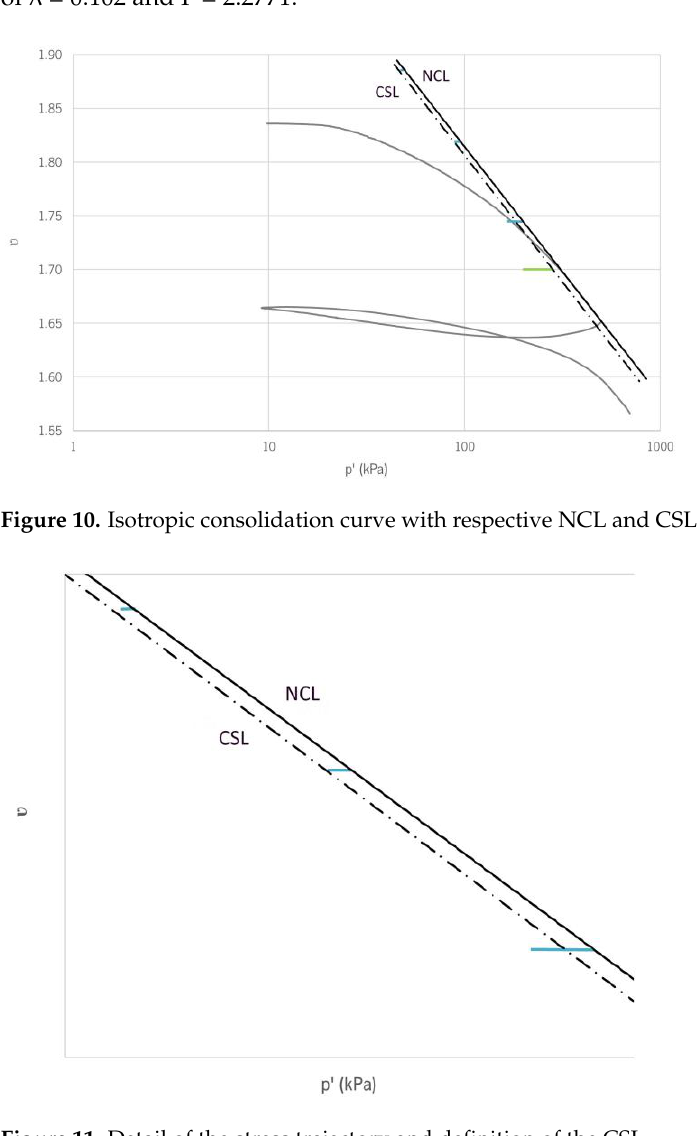
Table 3. Values of λ, Γ and k for typical soils .